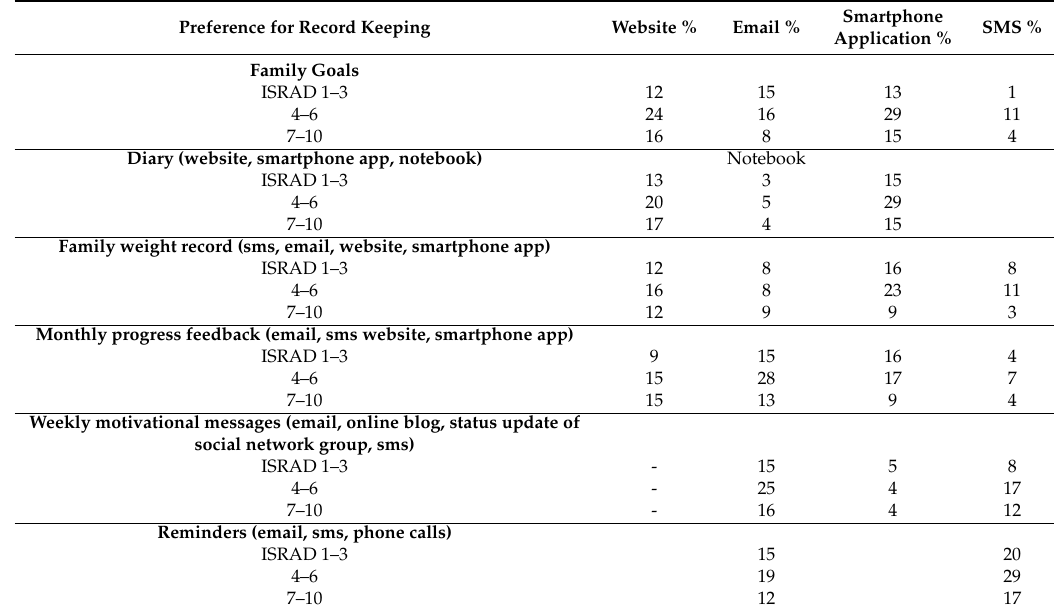
Table 3. Identified preferences of program content and contact by socioeconomic status (ISRAD scale